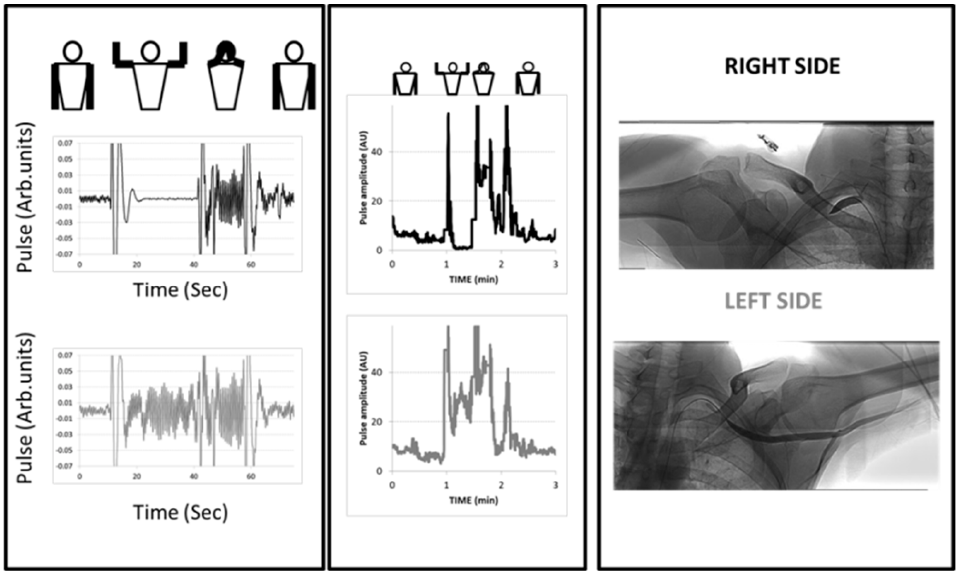
Figure 3. Example of an arterial digital pulse plethysmography (A-PPG) recording during the candlestick-prayer maneuver with unilateral pain on the right side and fatigability at arm elevation. Left panels represent a focus starting 10 s preceding the start of the maneuver and ending 10 s after return to the resting position on the right (black line) and left (grey line) sides. As shown, moving the arm results in ample signal artifacts. Here, pulsatility was lost 10 s after arm elevation and restored with increased amplitude during the prayer phase on the right arm, while the response on the left side was an increase from baseline during both candlestick and prayer attitude. The middle panel is the analysis of pulse amplitude throughout the period of recording (AU: from before normalization to the amplitude observed during the prayer phase). In the right panel are the angiographic results for the